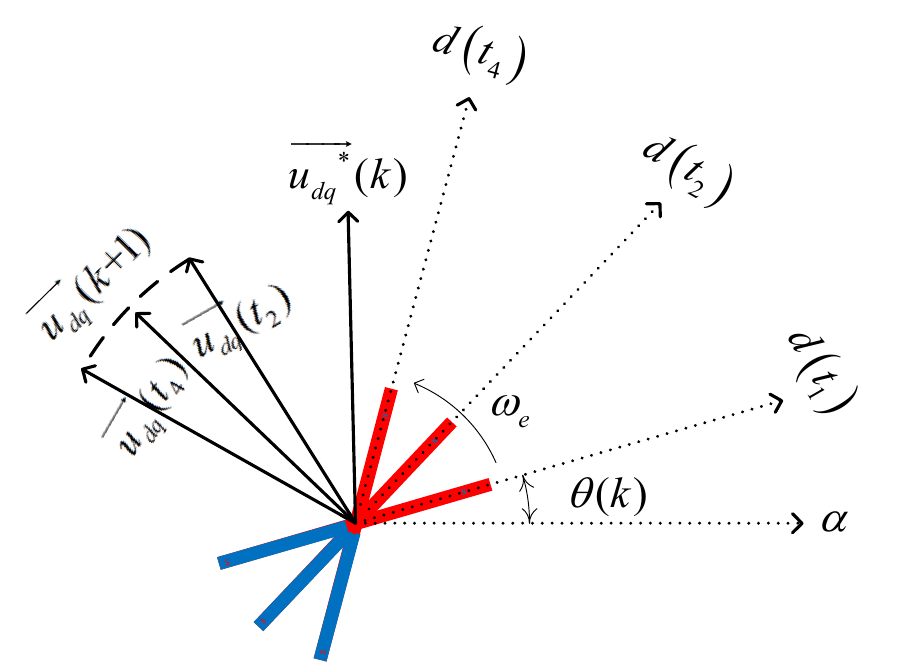
Figure 4. Voltage complex vector plot of a rotating PMSM.